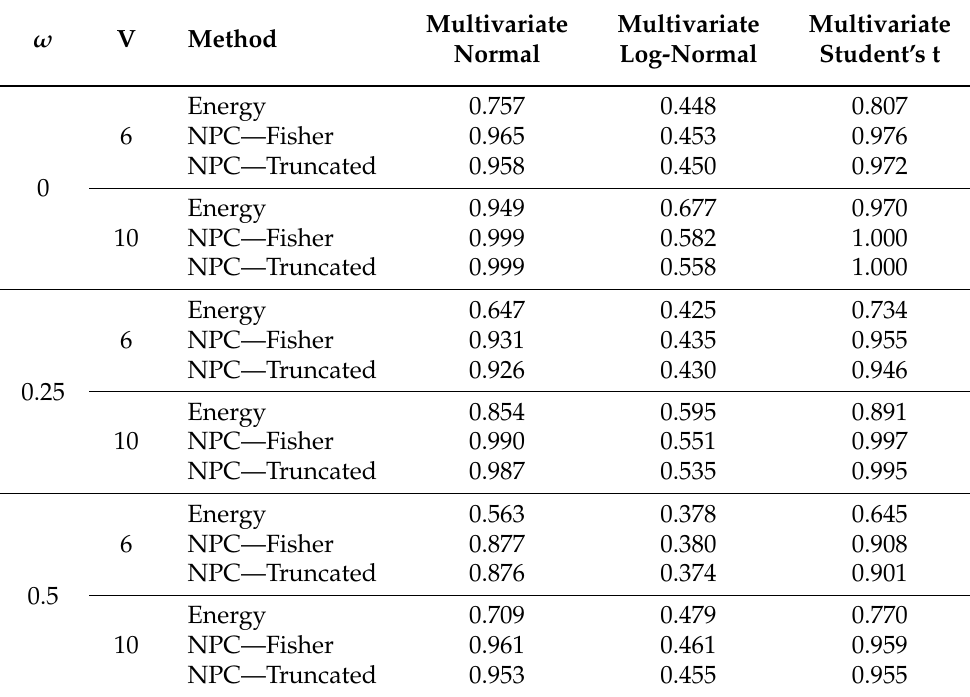
Table 2. Rejection rates with significance level α = 1% under the alternative hypothesis varying ω